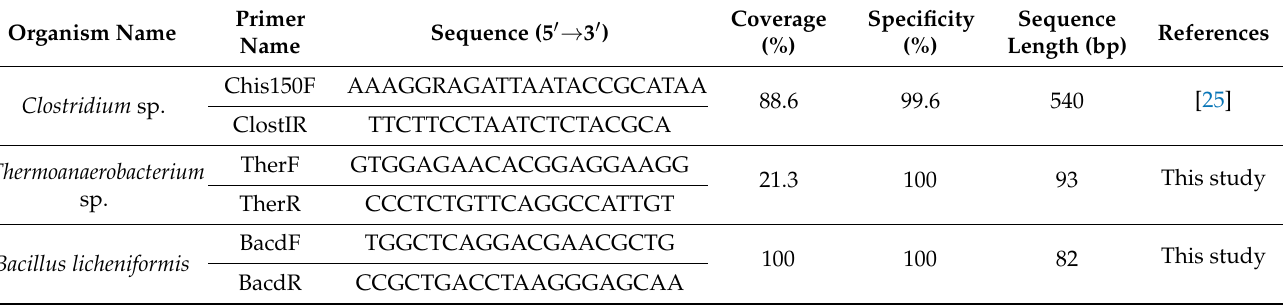
Table 1. Primers targeted to 16S rRNA were used for q-PCR in this